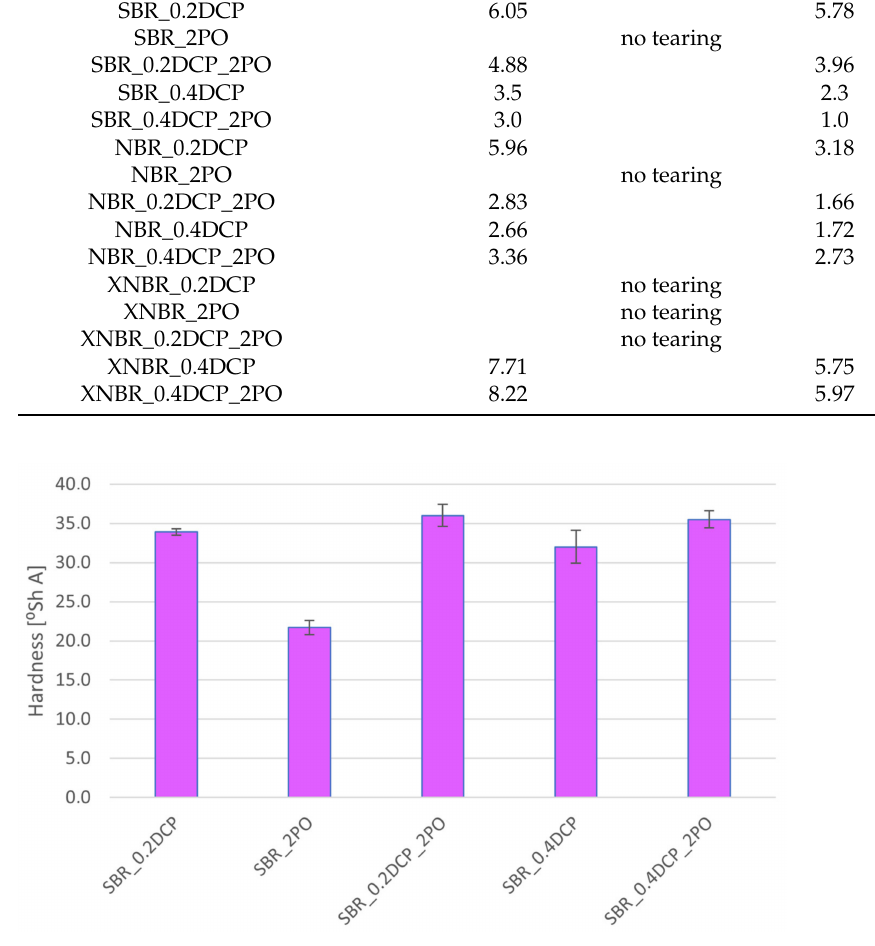
Figure 11. Influence of peroxide curing system modification on hardness of SBR